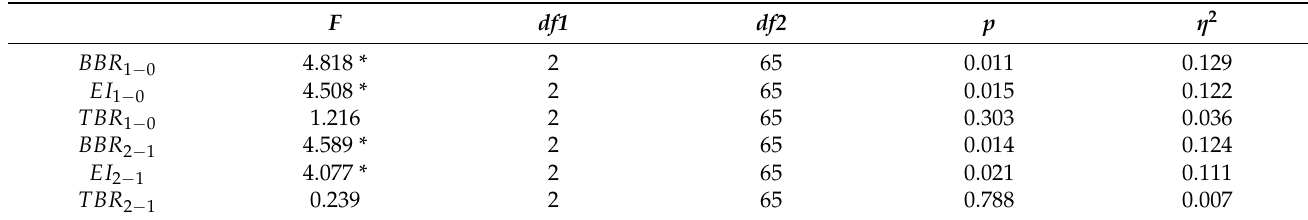
Table A13. Results of one-way ANOVA of PSD changes in each frequency band.